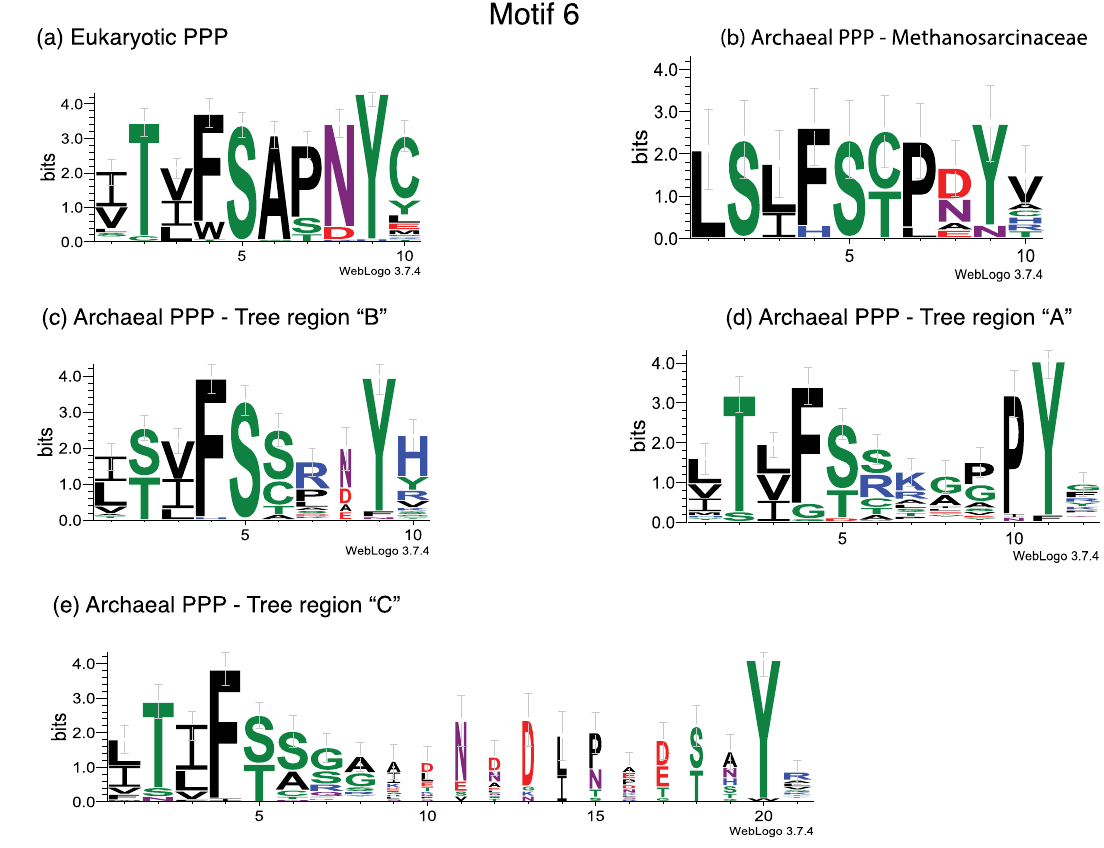
Figure 4. Residue conservation in Motif 6—graphical summary. Reference eukaryotic PPP sequences and candidate “EukaryoticPPP-Like” sequences from Archaea and Bacteria were collected, aligned, and phylogenetic trees constructed as detailed in “Methods”. Subalignments of the Motif 6 region were constructed as detailed in “Methods”. These were then converted into graphical summaries by the WebLogo3 server, as detailed in “Methods”. Each “stack” in the WebLogo (i.e. vertical set of characters) corresponds to a conventional alignment column. Conservation along the Y-axis of the WebLogo for each stack is given in units of “bits” of information. The frequency of occurrence of each character in the alignment column is represented by the height of that character in the WebLogo. The width of the stack corresponds to the number of gaps in the alignment column (i.e. columns with no gaps are widest, those with many gaps are narrowest). WebLogos were constructed from subalignments representing sequences in the major regions of the detailed phylogenetic tree of Supplemental Figure S7 and the radial phylogram of Fig. 3. The conventional alignments from which these WebLogo representations were constructed are presented as Supplemental Figure